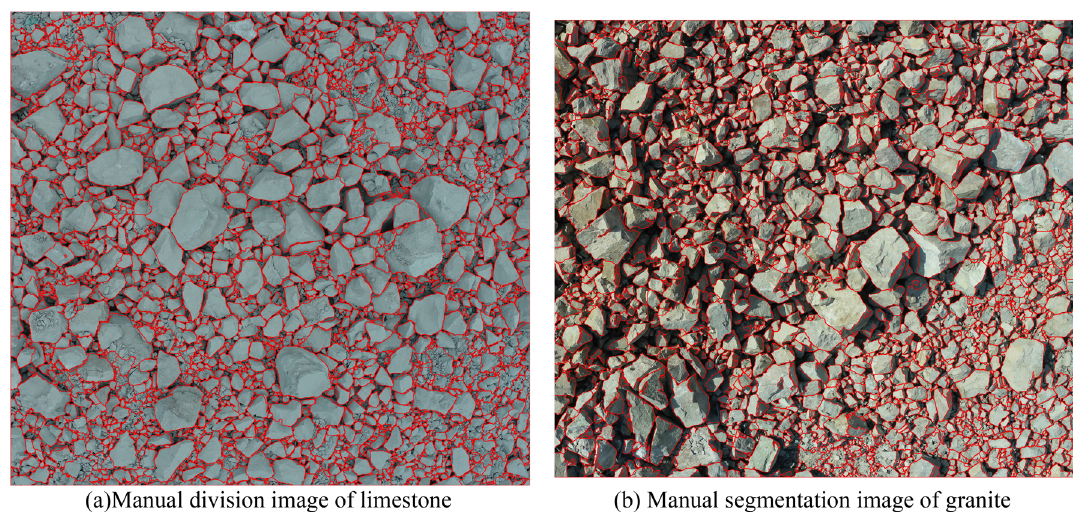
Figure 10. Manual segmentation